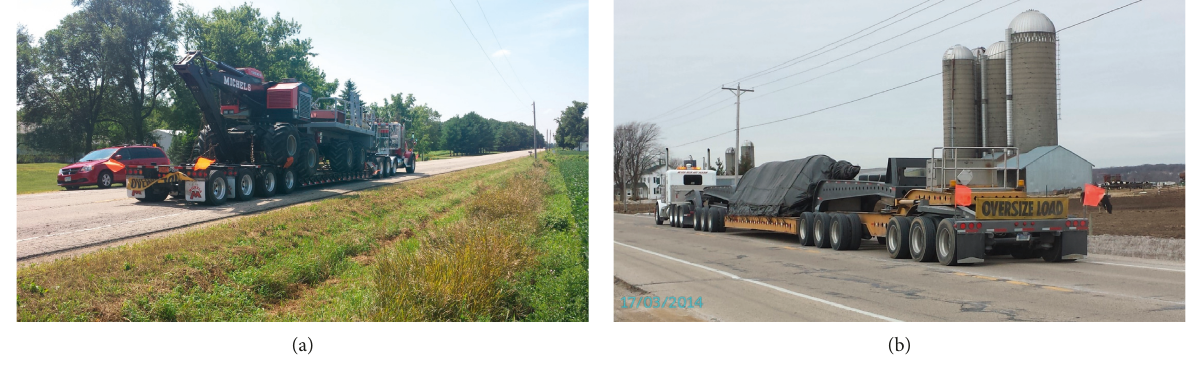
Figure 4: OSOW vehicles observed during field traffic counts.